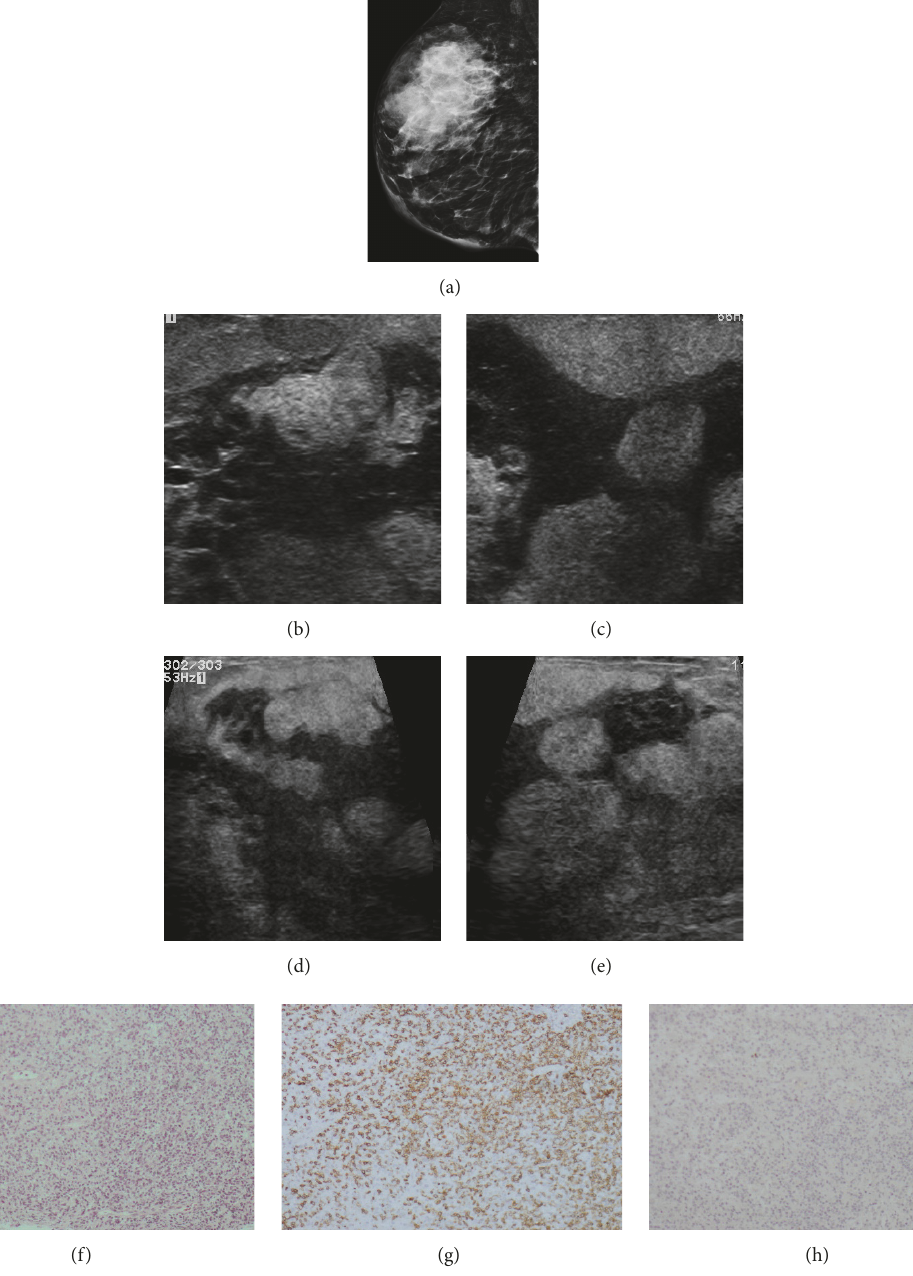
Figure 8: Case 8. A 57-year-old-woman with Epstein–Barr virus (EBV)-associated, extranodal natural killer (NK)-cell lymphoma of nasal type. In 2006, the patient was diagnosed with breast cancer,whichwas treated with sentinellymph node (SLN) biopsy and a total mastectomy. In 2016, the patient was admitted to our institution for an unusual nasal blockage and rhinorrhea over a 1-month period. Upon interrogation, the patient also reported progressive loss of vision in the left eye, which was associated with a mass. Notably, a palpable mass was appreciated in the right breast at the time of the evaluation ( a ). Mammogram showed an irregular mass with indistinct margins occupying the upper- outer quadrant of the right breast ( b–e ). Grayscale ultrasound demonstrated an irregular, solid mass with indistinct and angular margins, a heterogeneous echo pattern, and posterior features with a combined pattern. HE staining and immunohistochemistry analysis of the metastases. HE staining revealed the malignant cells in the breast tumor ( f ), and the immunohistochemistry analysis indicated that the cells were positive for CD45 ( g ), and negative for CKAE1-AE3 ( h